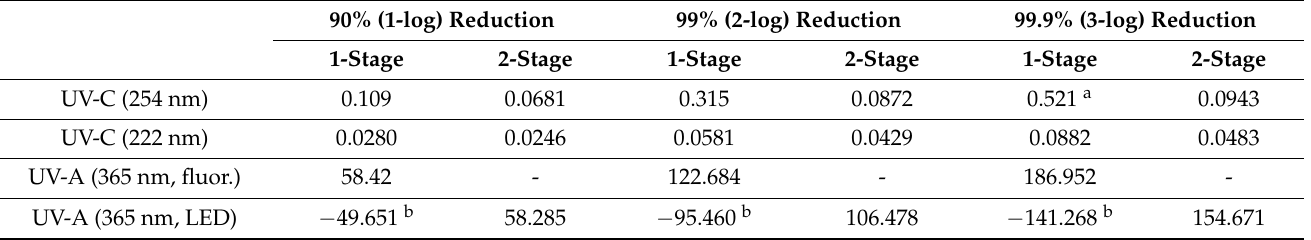
Table 3. Estimated the UV dose (mJ/cm 2 ) needed for target % aerosolized PRRSV reduction in fast-moving air, using both one-stage and two-stage inactivation